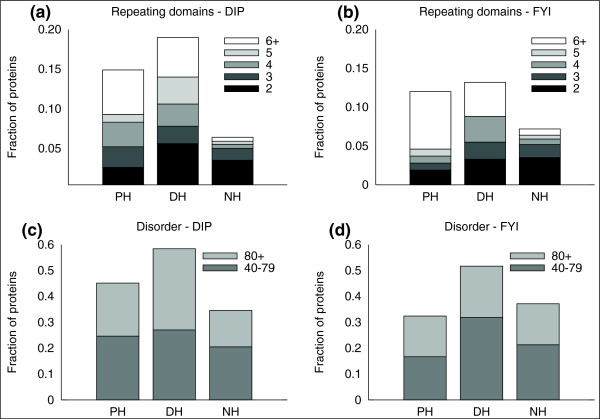
Repeating domains and disorder. Results are shown for party hubs (PHs), date hubs (DHs) and non-hubs (NHs). Repeating domains in (a) DIP and (b) FYI. A domain repeat is defined as two or more adjacent domains from the same family. Fractions of proteins with domain repeats containing 2, 3, 4, 5 or 6 or more domains are displayed. Fractions of proteins in (c) DIP and (d) FYI with disordered regions of lengths 40 to 79 residues and 80 or more residues are shown. Although 40 residues is a common cut-off for disordered regions, it is somewhat arbitrary and, therefore, 80 residues was added as an alternative cut-off.